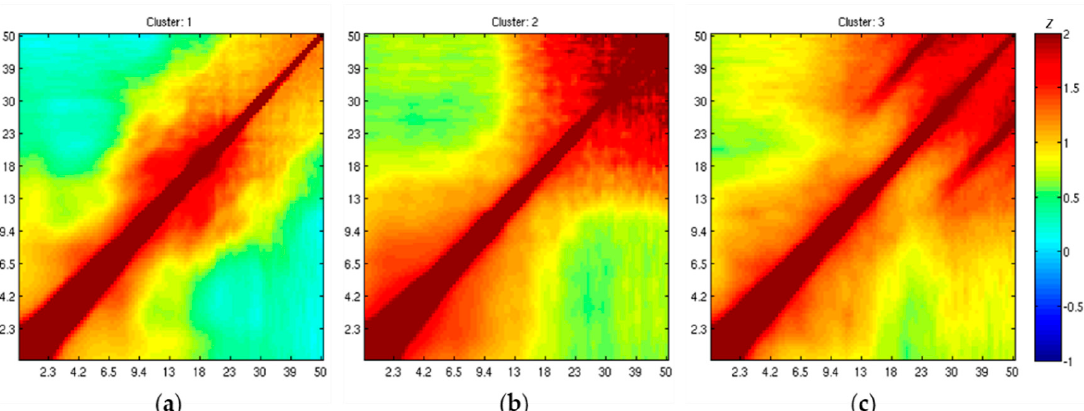
Figure 2. Matrices of standardized correlation for the different IC classes showing discernible patterns across the classes from highest-level analysis, where each of the standardized correlation is color-coded as represented in z scale: ( a ) The standardized matrix of brain class shows cross-frequency PPC between 6.5and 30 Hz and well-suppressed off-diagonal couplings; ( b ) the standardized matrix of eye class shows block-diagonalization on the lower end of the frequencies in 1-9.4 Hz and the higher end of the frequencies in 23–50 Hz; ( c ) the standardized matrix of eye class shows the characteristic parallel lines between 30 and 50 Hz.